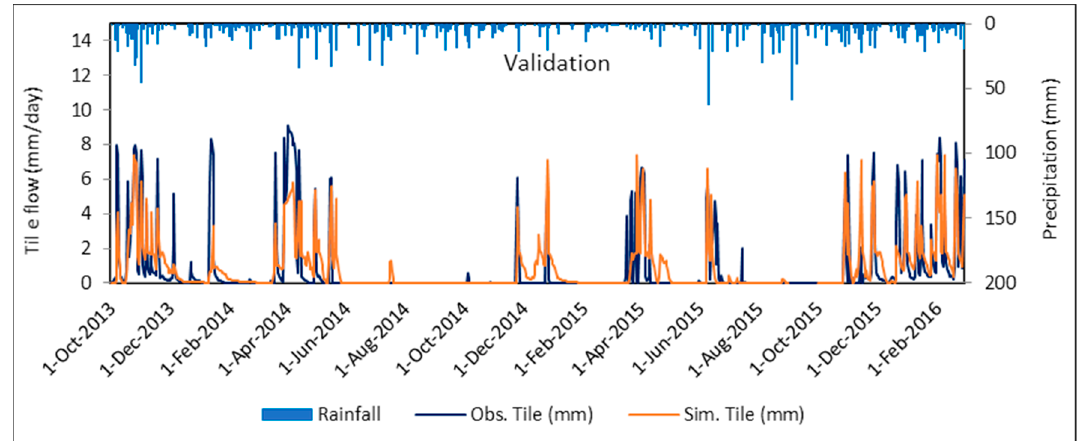
Figure 2. Measured tile discharge (blue line) and precipitation (blue bars) and simulated tile discharge (orange lines) during the model validation.